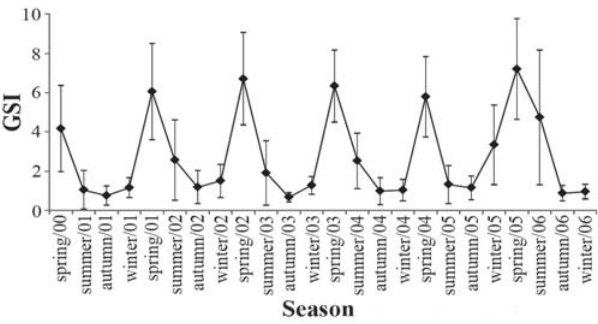
Fig. 6. Seasonal variation of Gonadossomatic Index (GSI) (mean ± SD) for males and females of Acestrorhynchus pantaneiro in the upper Uruguay